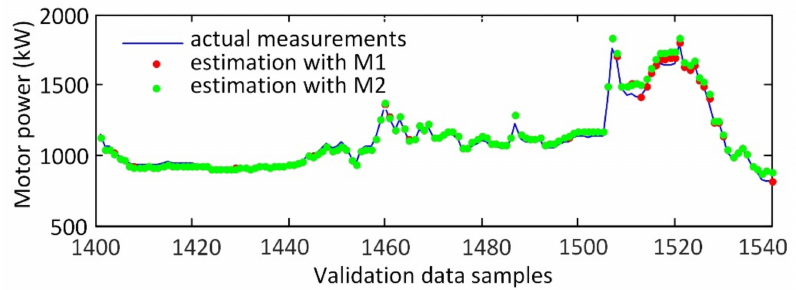
Figure 5. Estimation of motor power in validation dataset by using models M1 and